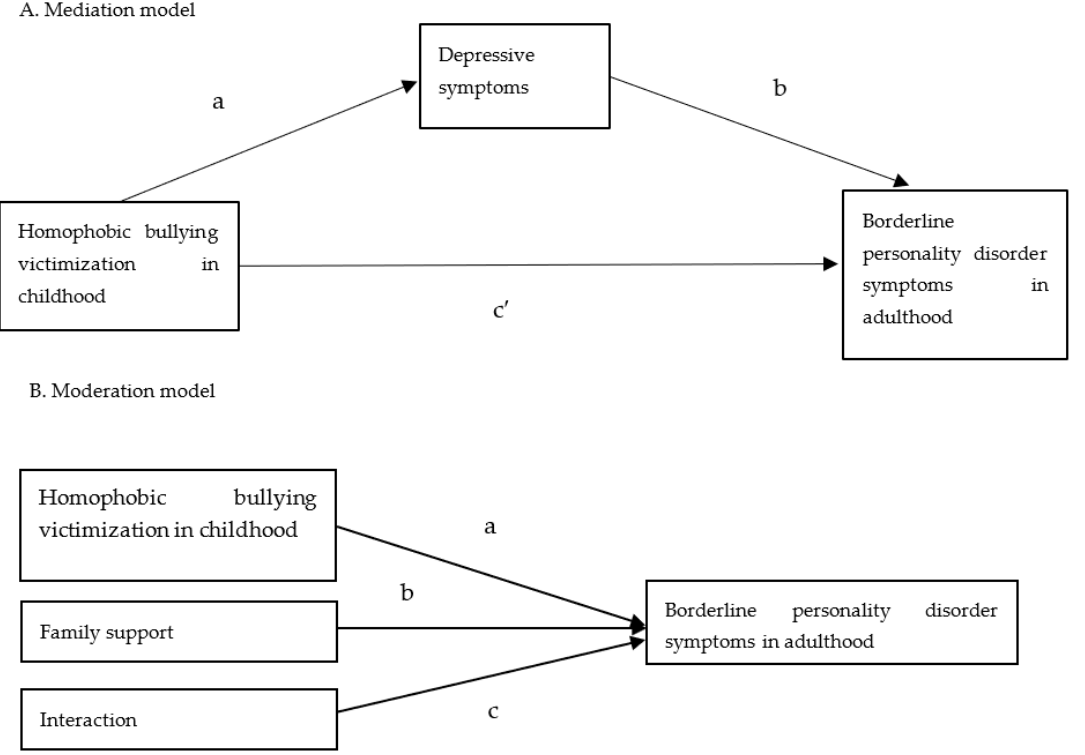
Figure 1. ( A ) Simple mediation and ( B ) simple moderation models depicted by statistical